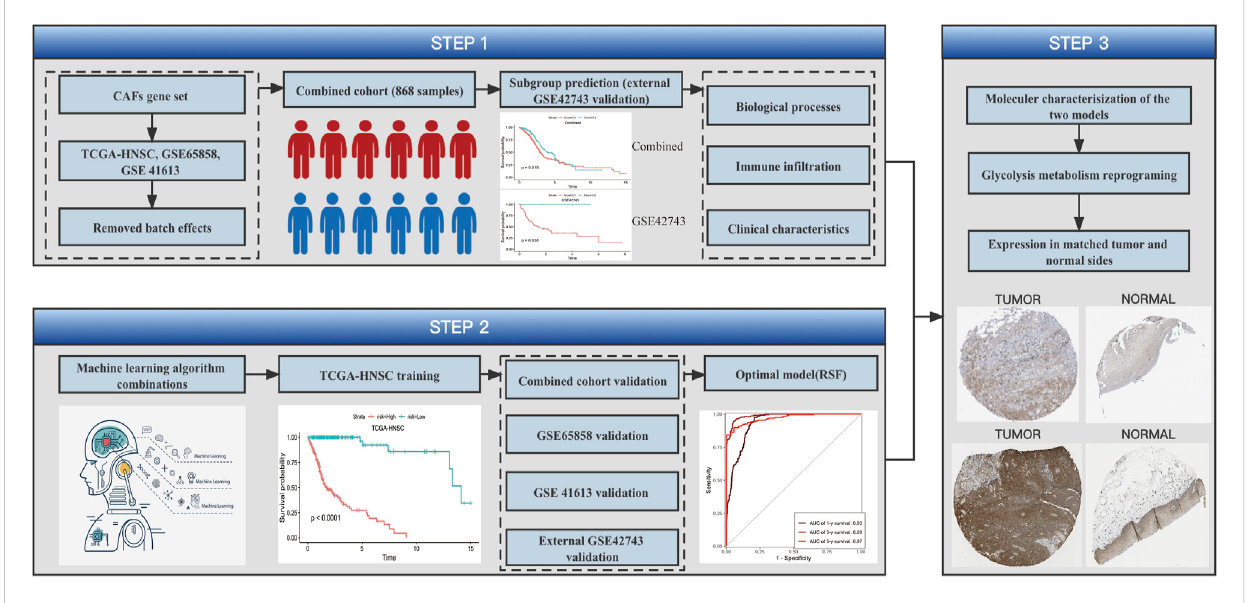
FIGURE 1 Work fl ow. The work fl ow of HNSCC cancer-associated fi broblasts signature